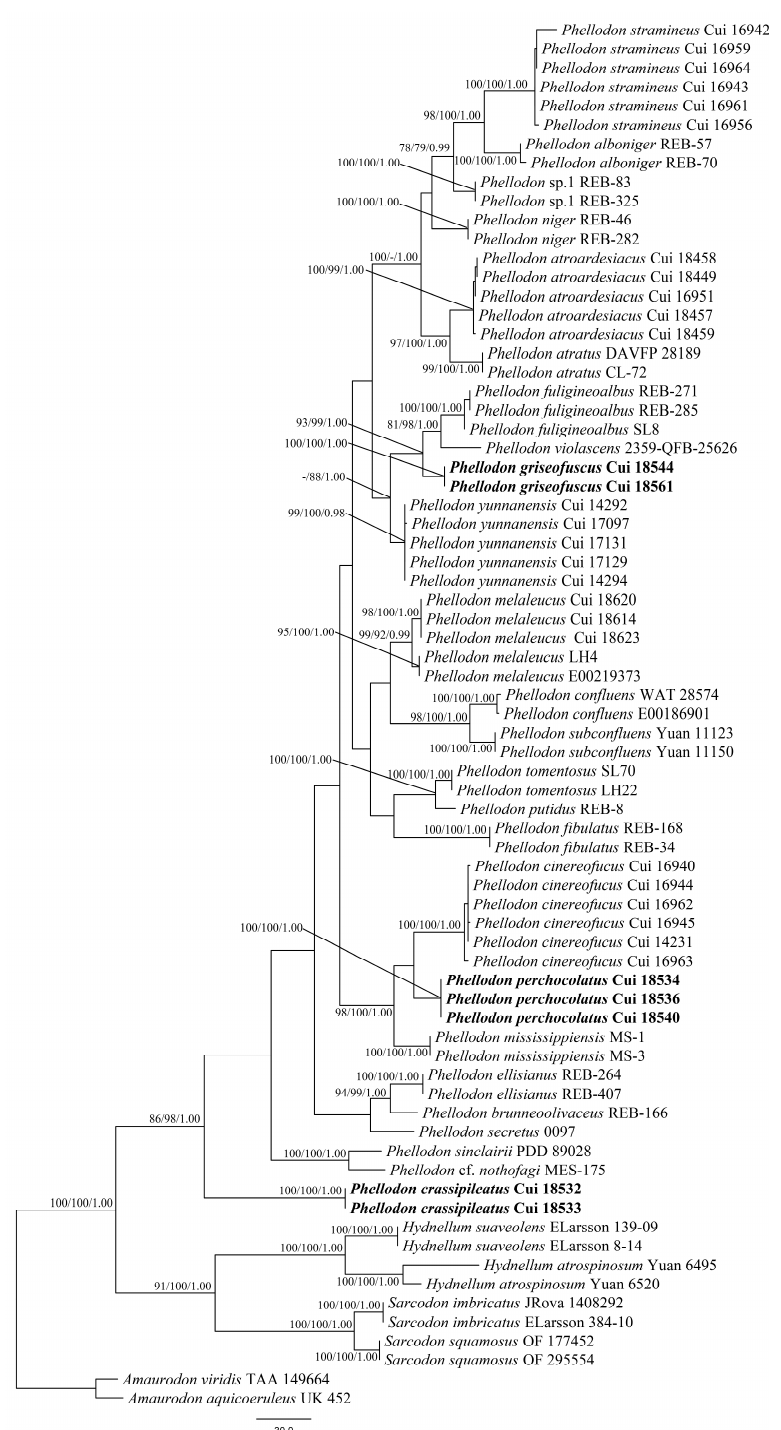
Figure 1. Maximum parsimony (MP) phylogram of the Phellodon species based on ITS sequences data. The supported branches are labeled with parsimony bootstrap values higher than 75%, maximum likelihood bootstrap values higher than 75%, and Bayesian posterior probabilities more than 0.95. Bold names = New species.